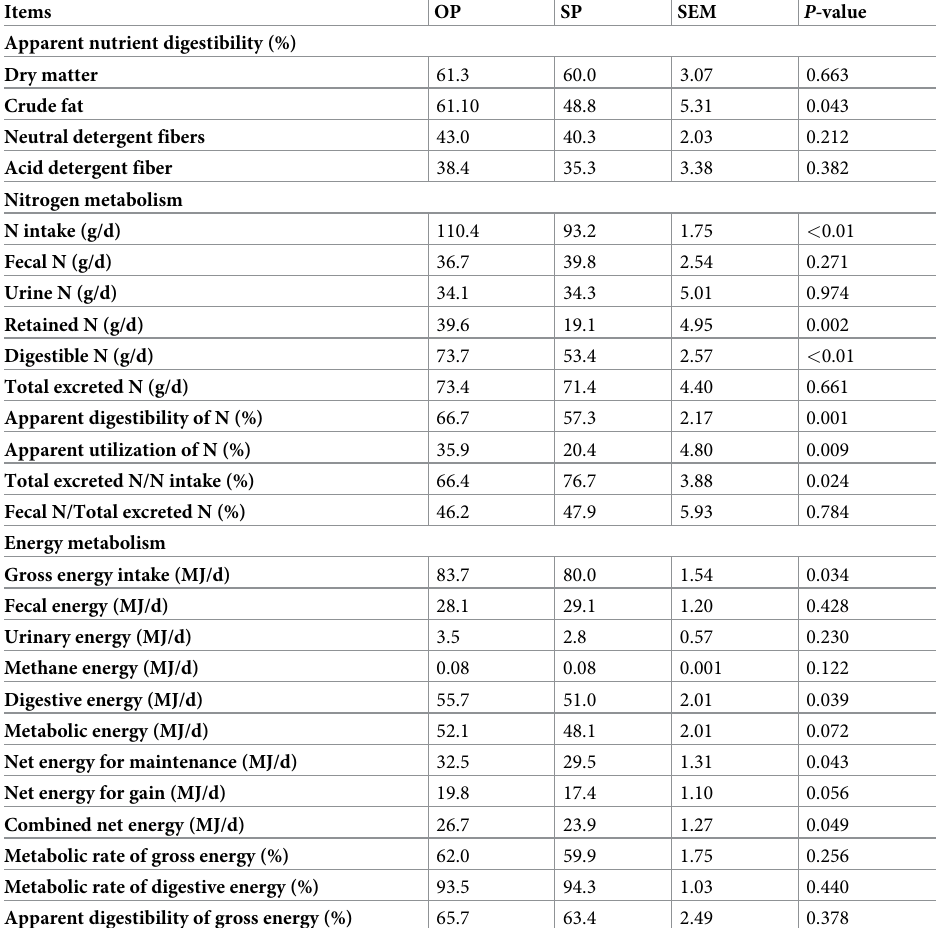
Table 3. Evolution of apparent nutrient digestibility, nitrogen metabolism and energy metabolism in calves fed OP and SP.